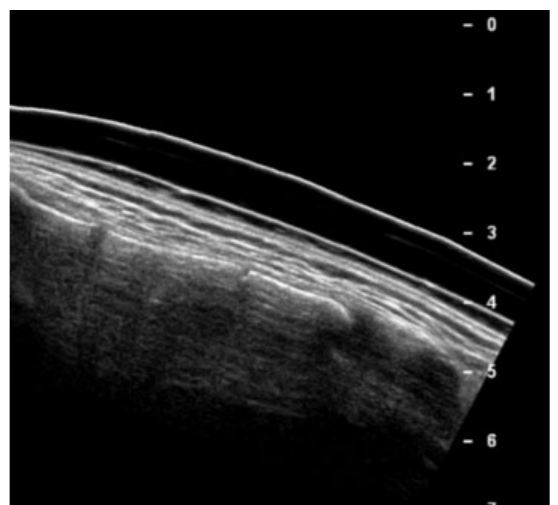
Fig. 5 Longitudinal ultrasonic image obtained 9 months after injury showing consolidation of the fracture and suf fi cient remodelling of the anterior outline of the